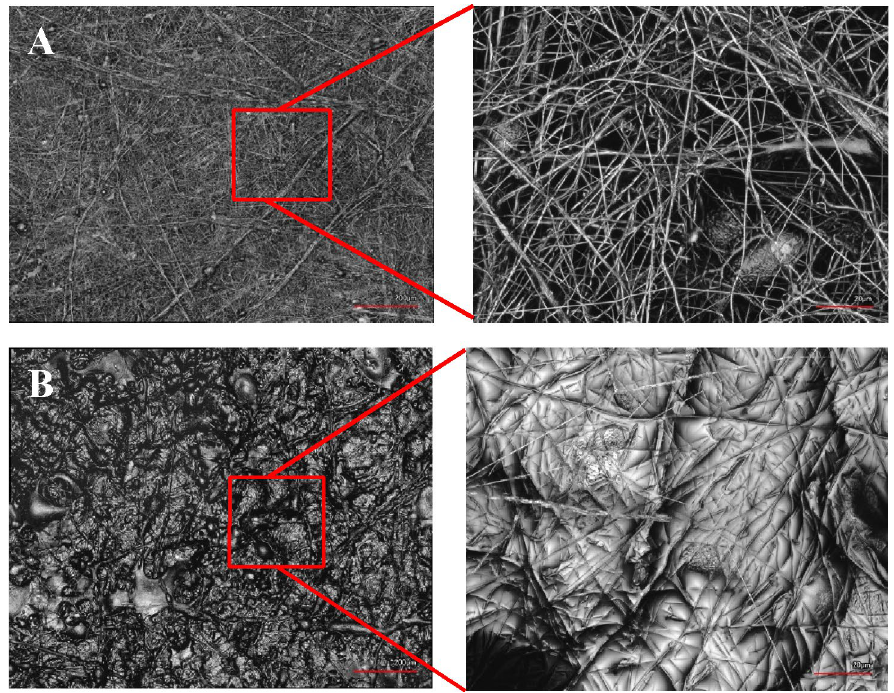
Figure 4. Representative 3D laser microscopy images: ( A ) the polymer laminate used to fabricate the device before saturation with PVP; the inset clearly shows the fiber structure; ( B ) the polymer film used to fabricate the device after saturation with PVP; the inset clearly shows the fiber structure where the laminate is partially coated with PVP